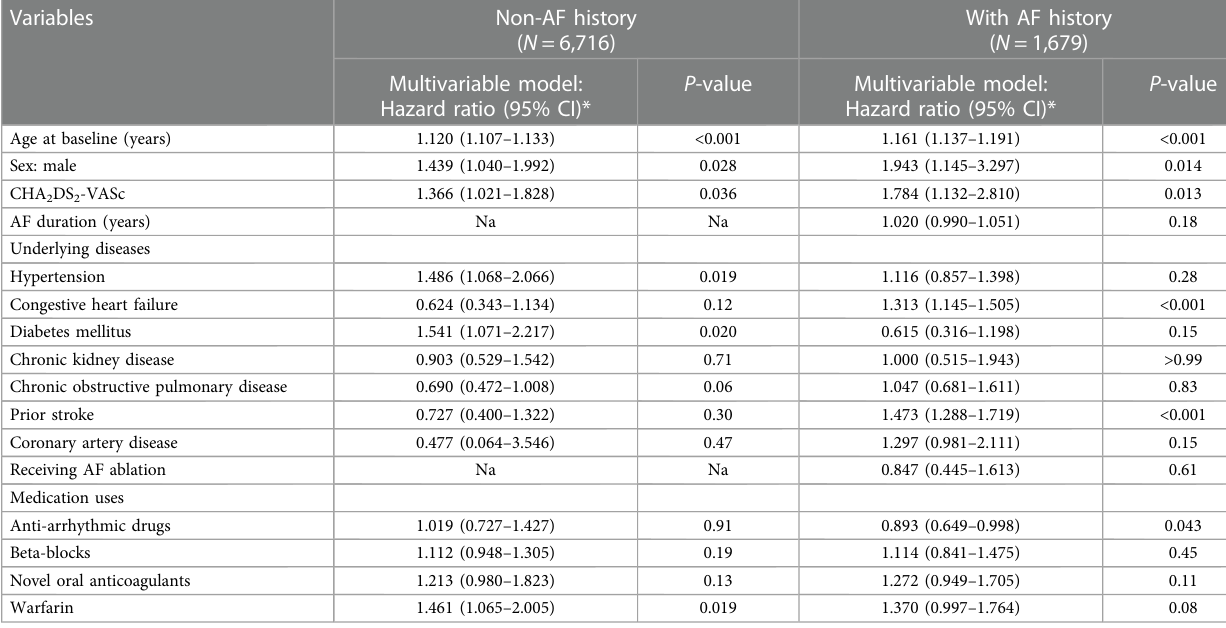
TABLE 4 Using fi ne-gray sub-distribution hazard model to evaluate the risk of cardiovascular deaths in dementia patients with atrial fi brillation.